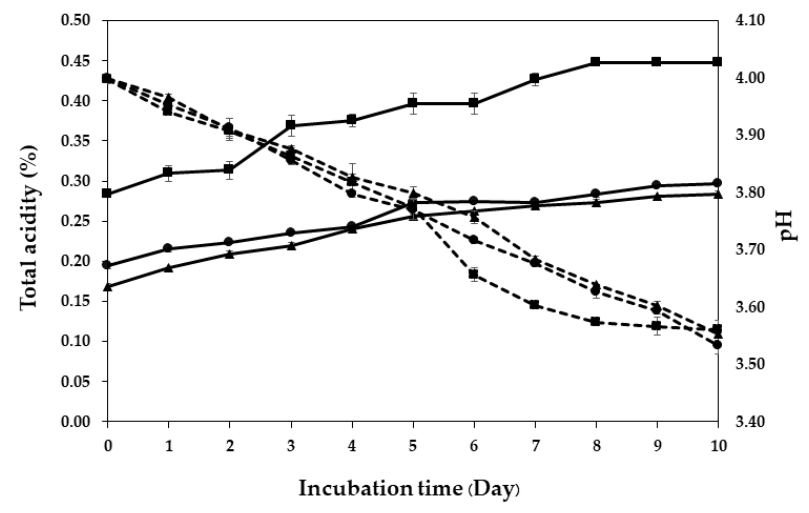
Figure 1. Total acidity (%) (solid line) and pH (dashed line) of pineapple wine ( (cid:4) ), pineapple wine mixed with dragon fruit without peel ( (cid:78) ), and pineapple wine mixed with dragon fruit with peel ( • ) during wine fermentation.